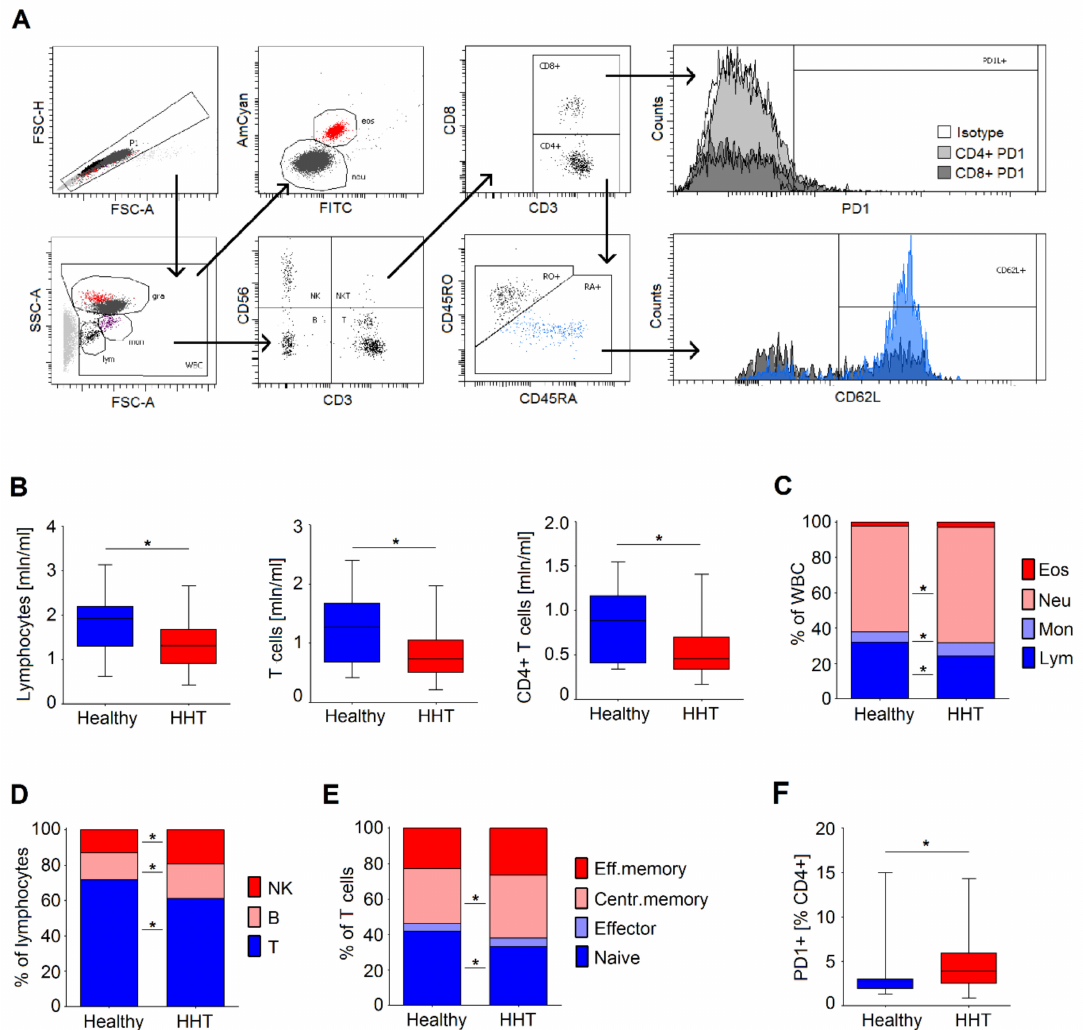
Figure 1. White blood cell populations in hereditary hemorrhagic telangiectasia (HHT) compared